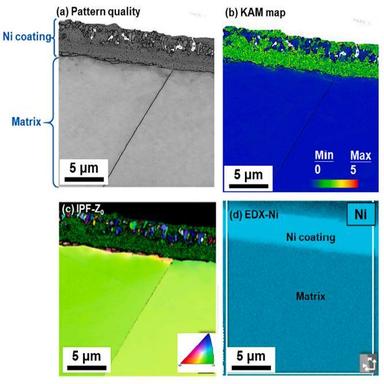
EBSD analysis of the near-surface after vibration polishing, (a) the pattern quality, (b) KAM map, (c) IPFZ, (d) EDX element mapping of Ni.